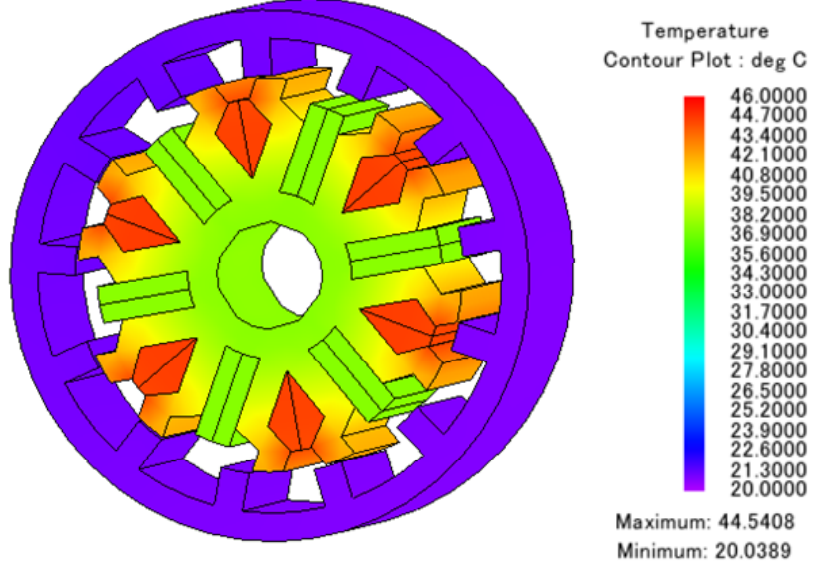
Figure 19. Thermal analysis of the proposed OR-FEFSM.